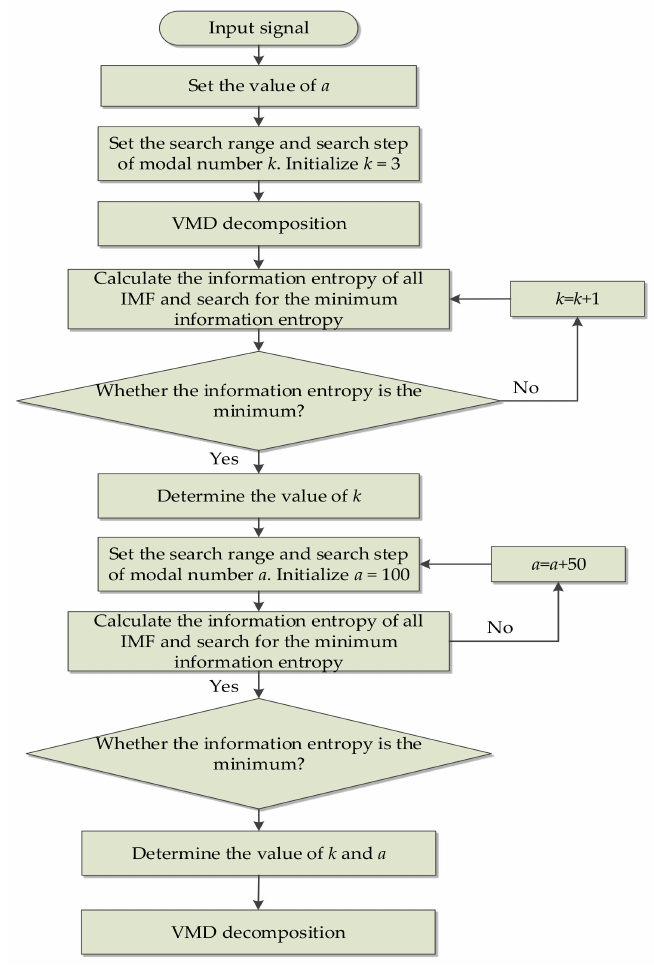
Figure 2. Parameter optimization process of